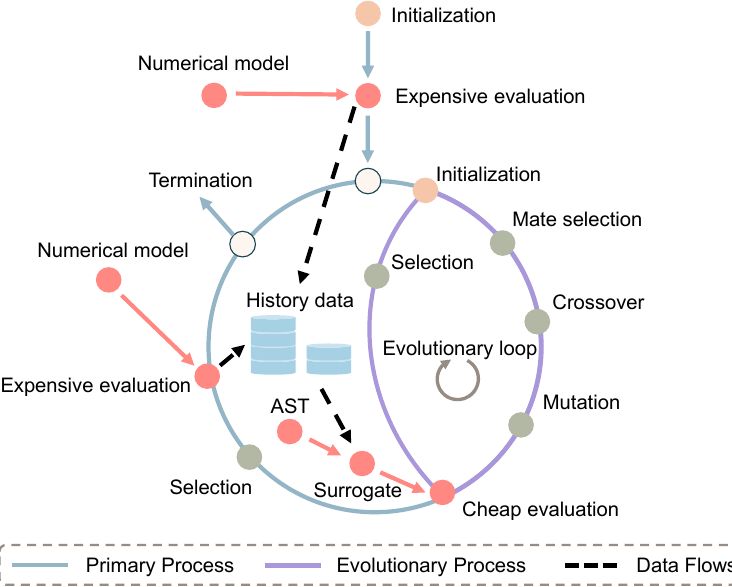
Figure 2. The flow chart of the proposed surrogate-assisted simulation-optimization method.